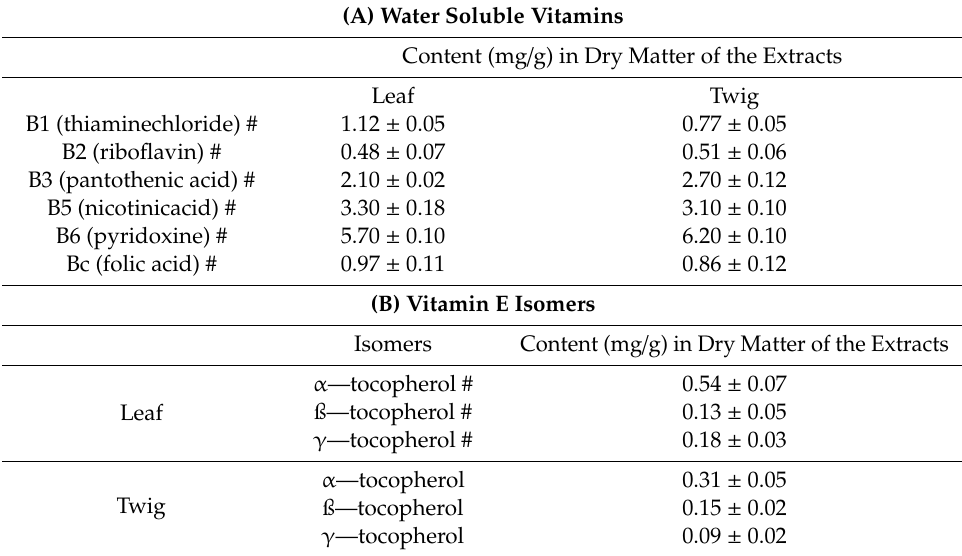
Table 2. Total content of water soluble vitamins (A) and vitamin E isomers (B) in dry matter of the leaf and twig extracts from R. canina .